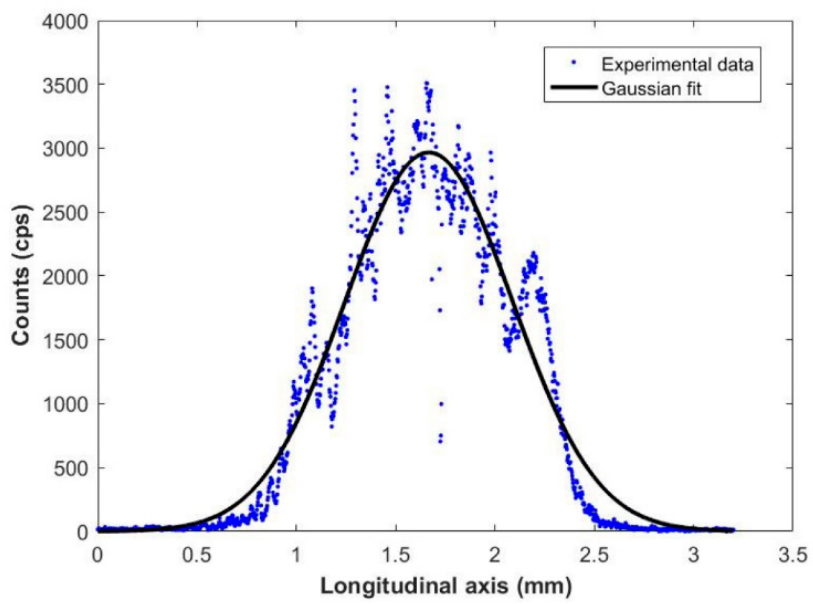
Figure 4. Measured laser pulse spatial profile (assumed axisymmetric) [37,39], with permission from ASME, 2019.